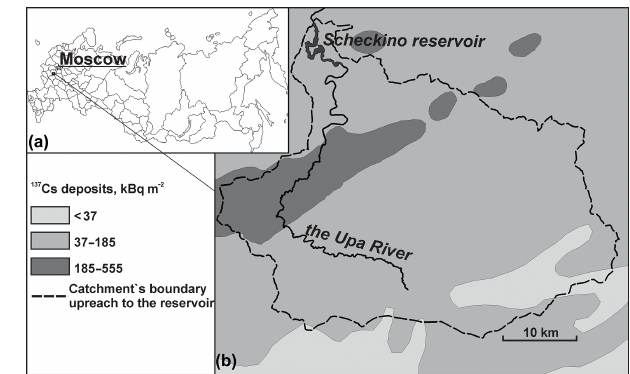
Figure 1. Location of the Upa river basin (a) and map of Chernobyl-derived 137 Cs deposition in the Upa River catchment upstream the Scheckino reservoir (Izrael, 1998) decay corrected for 1 May 1986 (b)